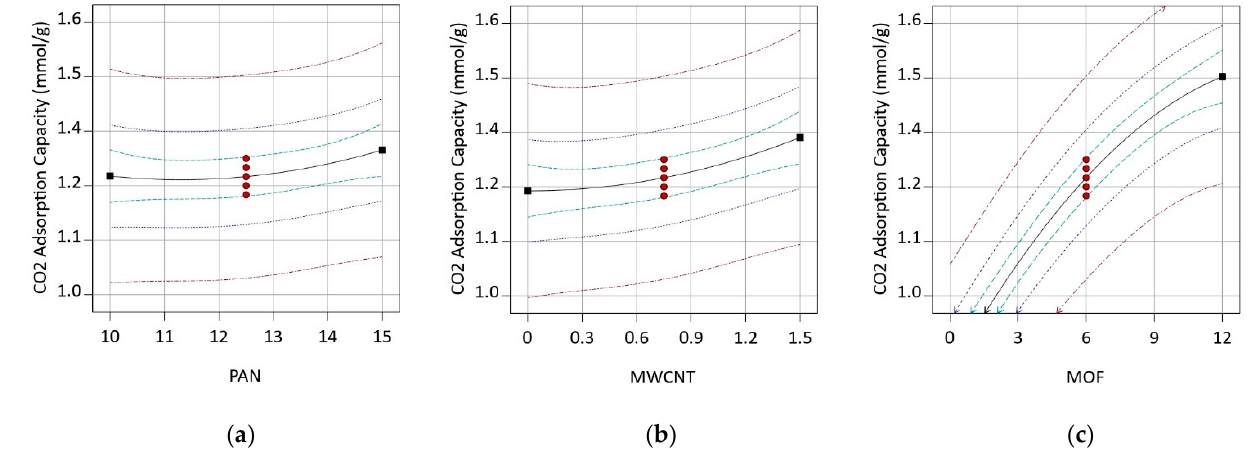
Figure 8. One-factor graphs of variables concentration effect on CO 2 adsorption, ( a ) PAN ( b ) MWCNT ( c ) MOF.